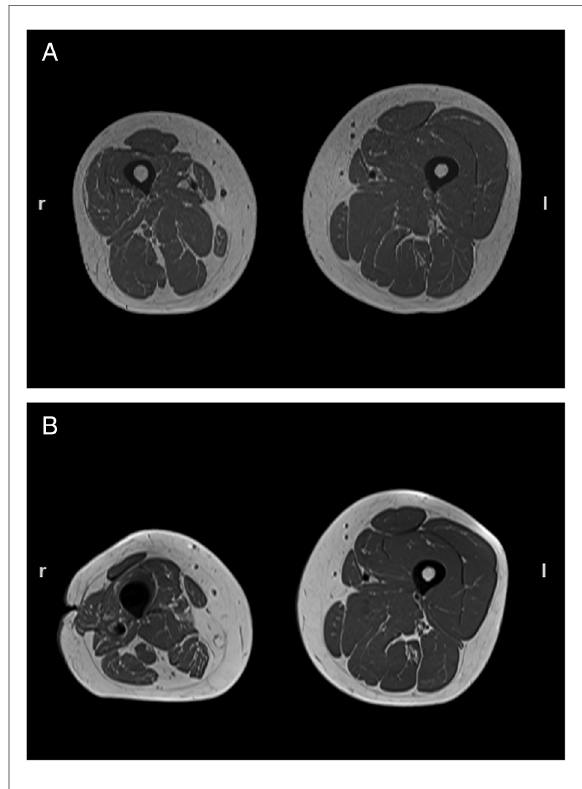
FIGURE 2 Transverse MRI of both thighs taken prior to transfemoral amputation ( A ) and 9 months after ( B ). Muscle volumes of the right (affected) thigh were 1,781 and 1,668 cm 3 , while those at the corresponding contralateral side were 2,750 and 3,378 cm 3 ,